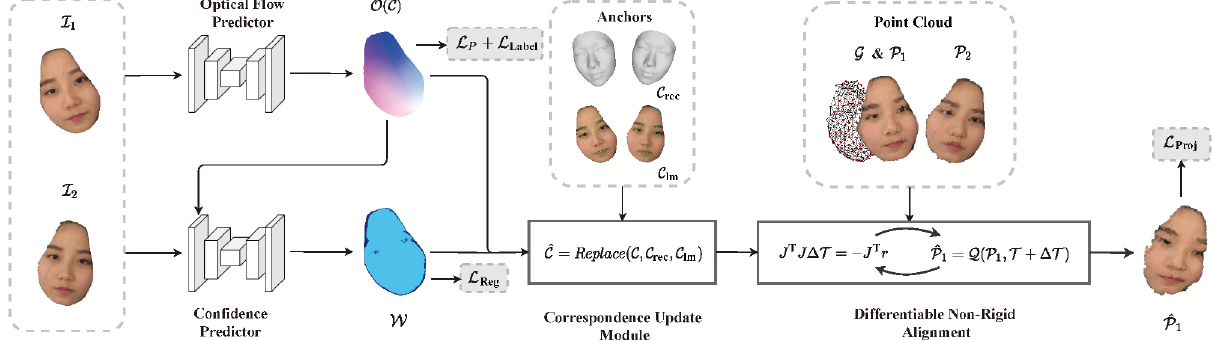
Fig. 1 Overview of our self-supervised optical flow estimation architecture. Given a pair of images I 1 and I 2 , the optical flow prediction module outputs dense optical flow O from I 1 to I 2 . Then, a confidence map W for O is estimated by the confidence weight module. To stabilize the self-supervised learning, we utilize 3D face reconstruction and landmark detection to construct coarse correspondences C rec and C lm . Next, a differentiable alignment module takes C rec , C lm , O , W , and a deformation graph defined on the point cloud of I 1 to produce an optimal alignment ˆ P 1 . Two types of self-supervised losses are used. The first directly acts on O and W to increase the quality of 2D matching. The second aims to improve the matching via constraints on the optimal alignment ˆ P 1 . Face parsing is used in our loss function to provide semantic